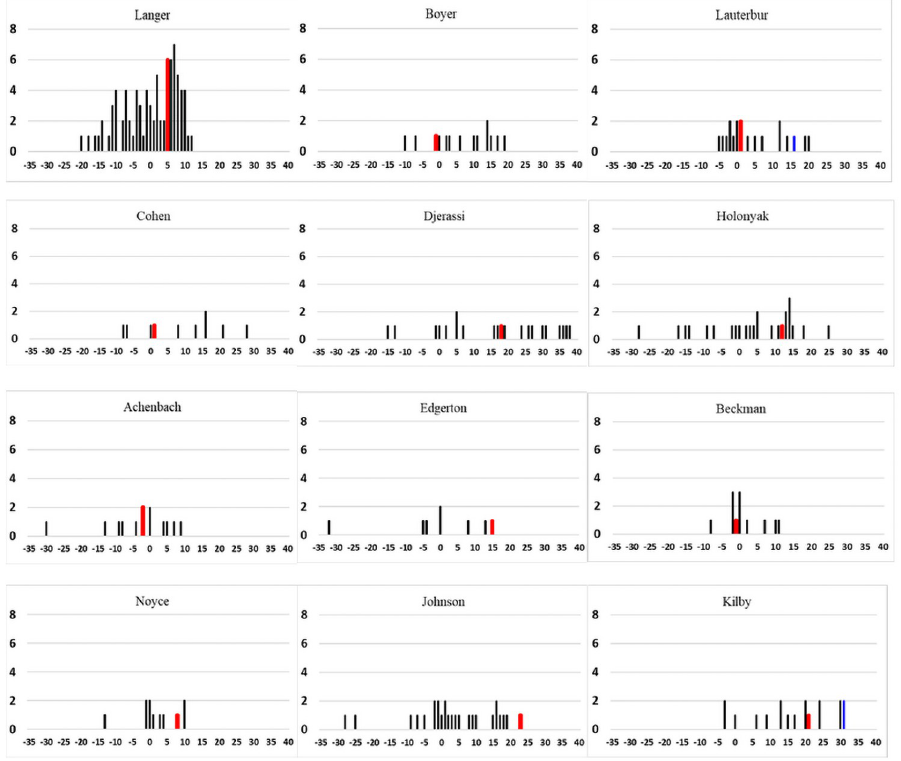
Fig 1. Number of awards per